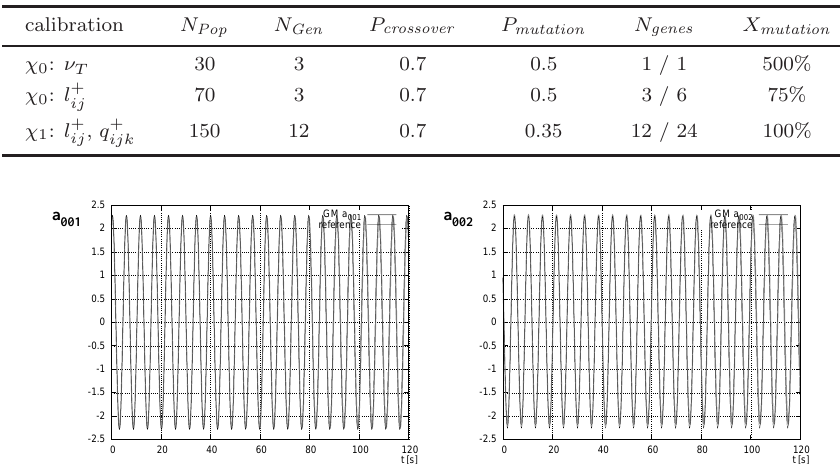
Table 3. Parameters of two-equation model calibration.